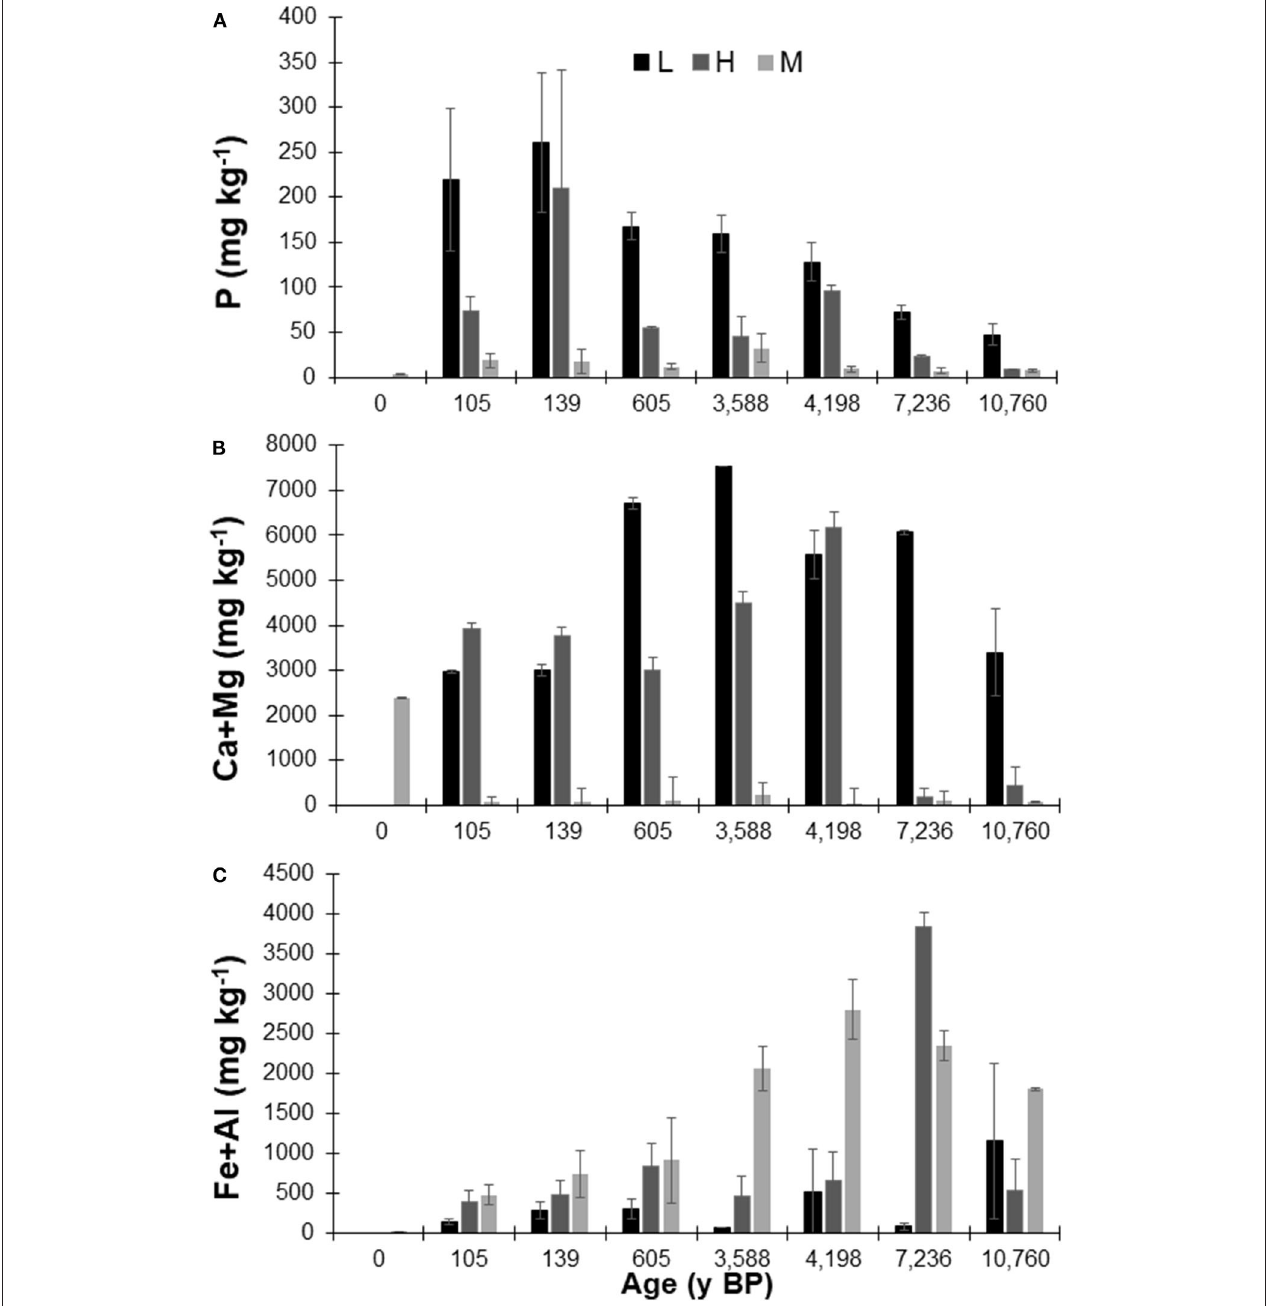
FIGURE 2 | Average Mehlich-3 extractable (A) phosphorus (P), (B) calcium (Ca) + magnesium (Mg) and (C) iron (Fe) + aluminum (Al) concentrations within the select litter (L), humic-enriched organic (H) and mineral horizon (M) samples used for P-NMR analysis from the Calvert Island, BC chronosequence. Values are means ± standard deviation; n = 2